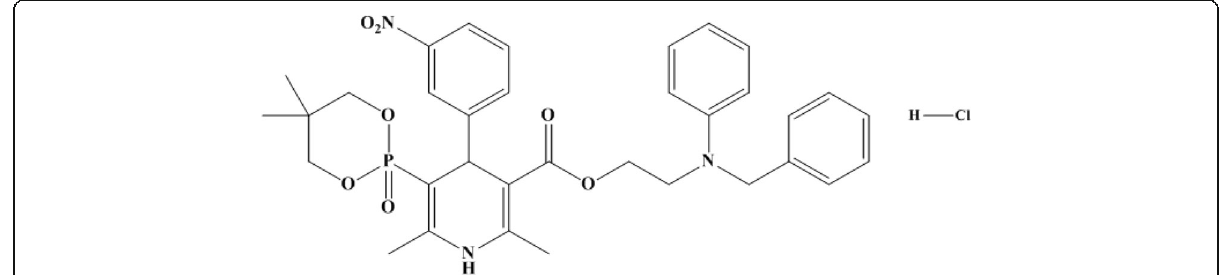
Fig. 1 Chemical structure of efonidipine